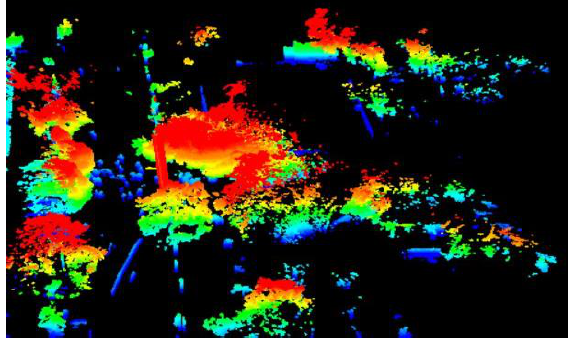
Figure 8. Off-ground 3D Point cloud view with normalized elevation.